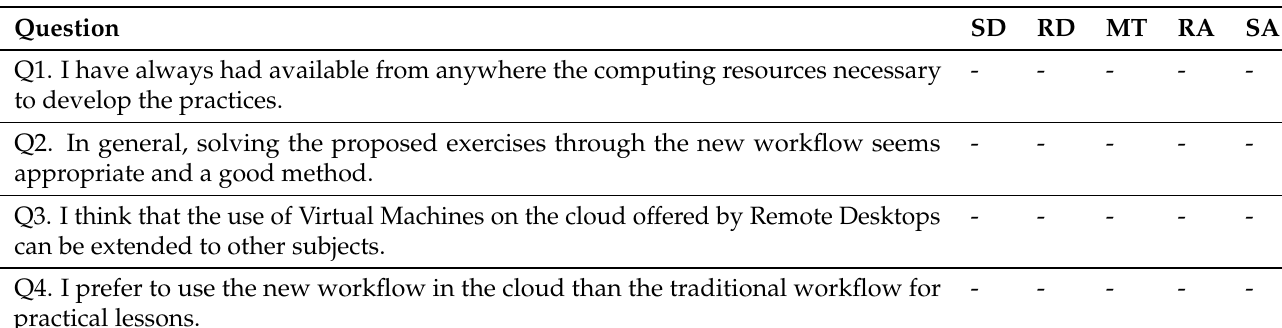
Table 4. Questionnaire answered by the pilot use case students after working on the two assignments with ACTaaS. Strongly Disagree (SD), Rather Disagree (RD), Middle Term (MT), Rather Agree (RA) and Strongly Agree (SA). Question SD RD MT RA SA Q2. In general, solving the proposed exercises through the new workflow seems appropriate and a good method.